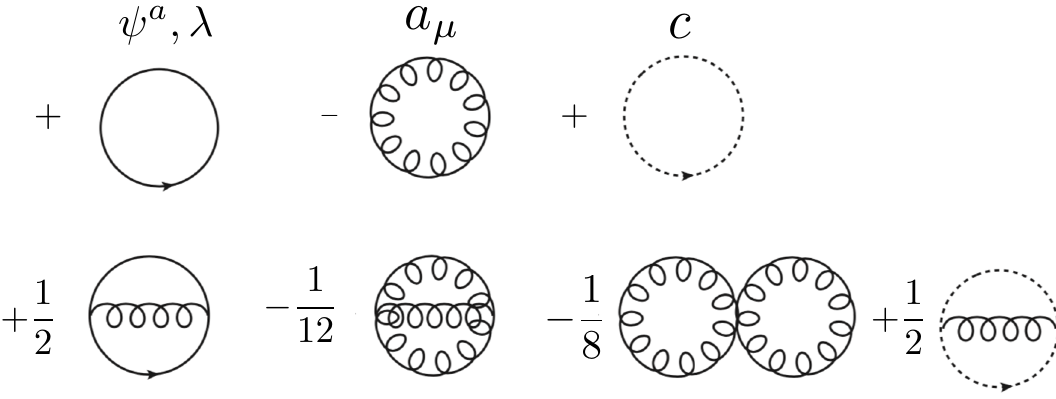
Figure 4 . Feynman diagrams for the gauge holonomy potential at one- and two-loop order for = 1 ) fermion. Diagrams are N f -Dirac fundamental fermions and one-adjoint Majorana ( N Dirac adj 2 reproduced from [25, 27] and slightly generalized according to new matter content. Up to two-loop order, the adjoint and fundamental fermions are decoupled in their contributions. In the graded case, where we insert ( − 1) F Q N f e i(cid:15) a Q a into the partition function, we determine the potential for a =1